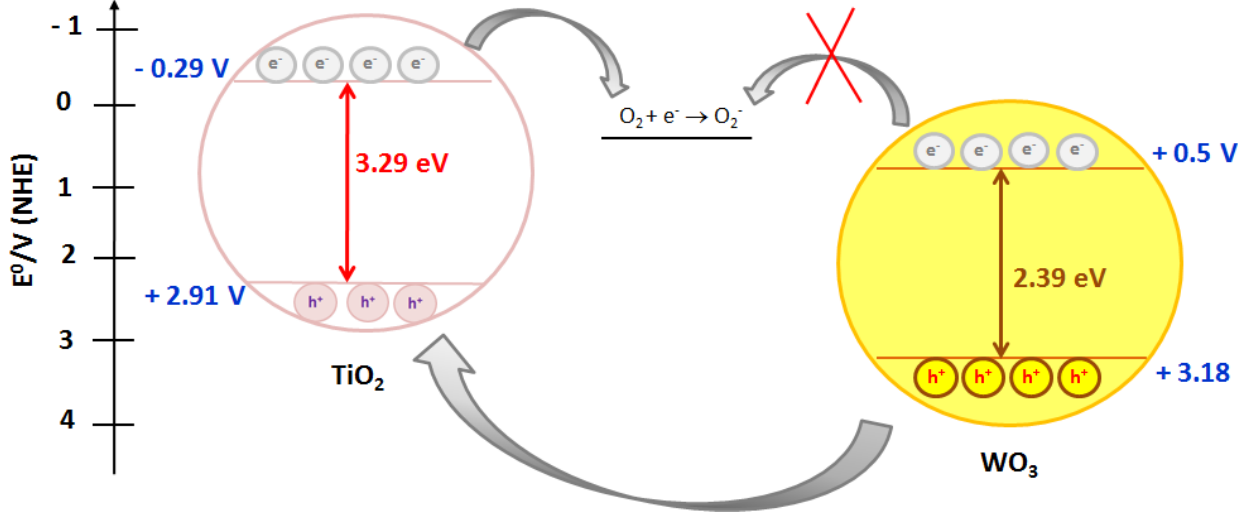
Figure 1. Photocatalytic mechanism of WO 3 − loaded TiO 2 under light irradiation.